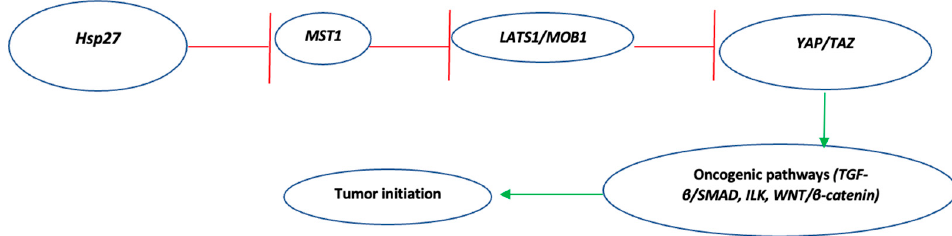
Figure 1. Summary of Hsp27-mediated modulation of the Salvador-Warts-Hippo (SWH) pathway, eventually leading to tumorigenesis. Green indicates activation, Red indicates inhibition. Key: MST1, macrophage stimulating 1; LATS1, large tumor suppressor kinase 1; MOB1, MOB Kinase activator 1A; YAP, Yes-associated protein; TAZ, PDZ-binding motif.